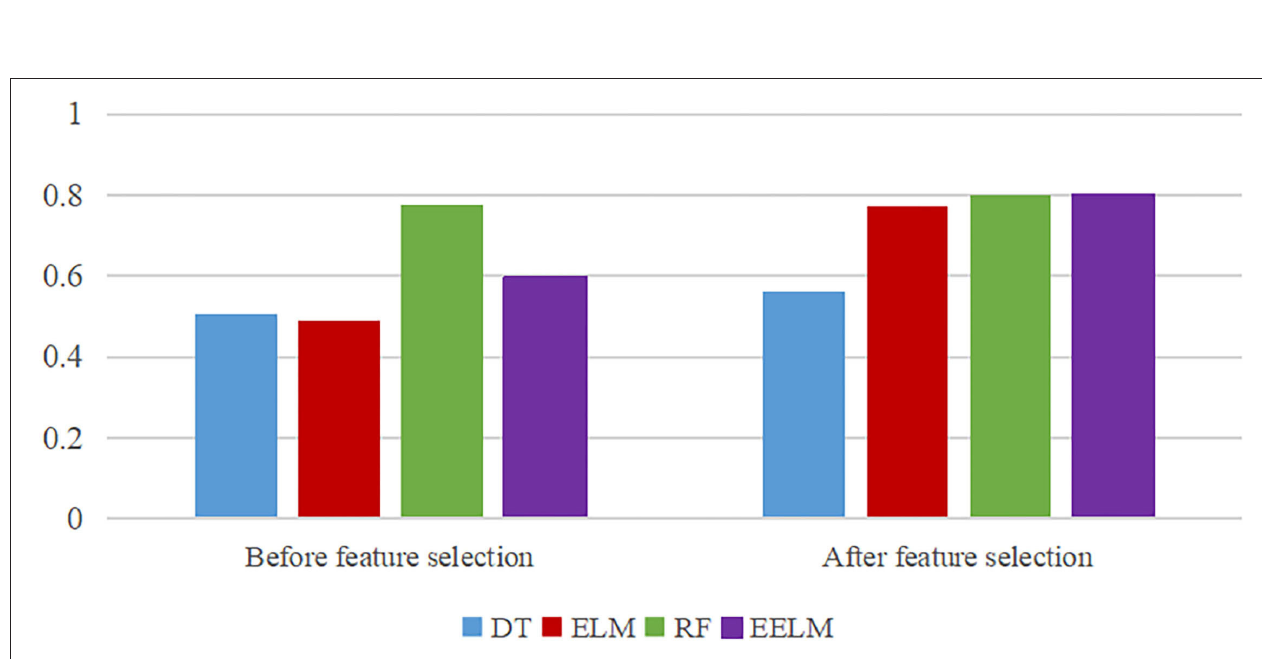
FIGURE 7 | Efficacy of feature selection